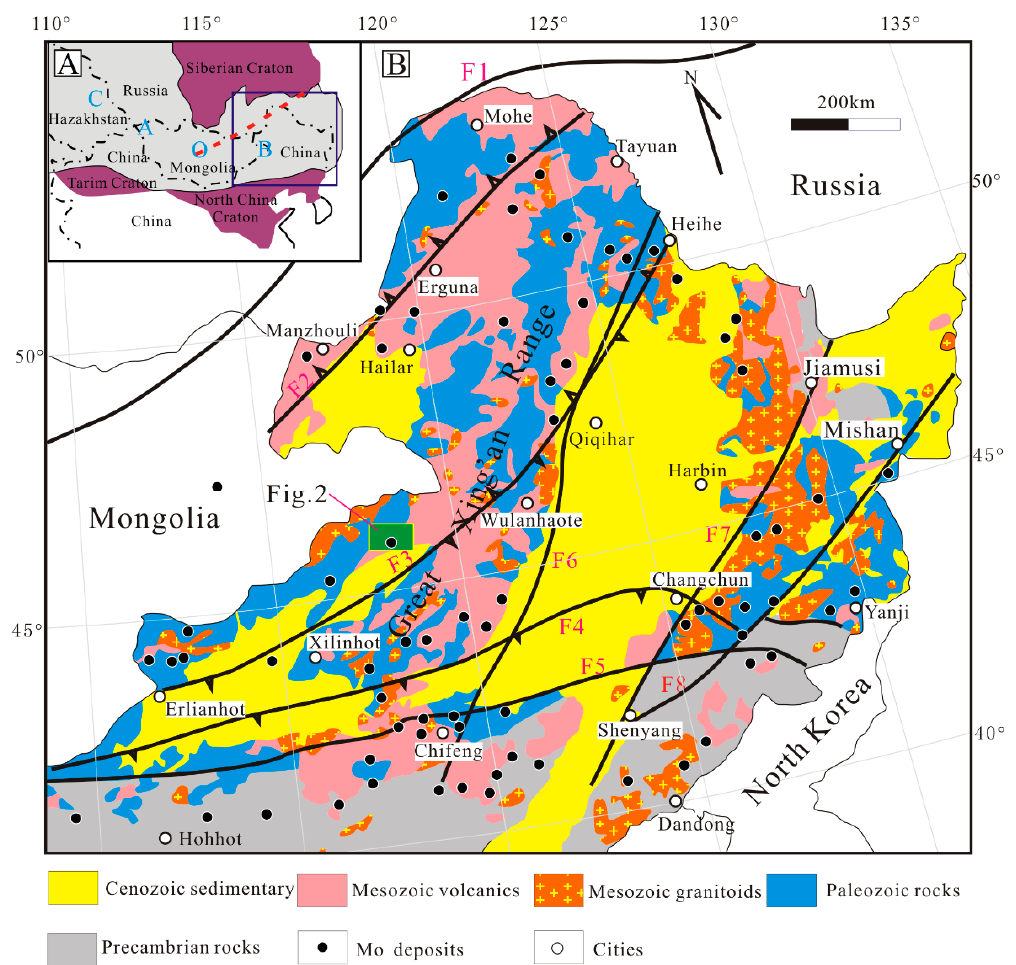
Figure 1. Distribution of the Mesozoic granitoids and Mo deposits in the Great Hinggan Range (GHR) and adjacent area. F1: Mongolia–Okhotsk suture belt; F2: Derbugan fault; F3: Erlian–Hegenshan Fault; F4: Xilamulun river fault; F5: Kangbao–Chifeng fault; F6: Nenjiang fault; F7: Yilan–Yitong fault; F8: Dunmi fault. CAOB: Central Asian Orogenic Belt. ( A ) Simplified tectonic map of CAOB showing major tectonic phases surrounding the GHR (modified after [2]). ( B ) Simplified geologic map of the GHR and its adjacent areas (modified after [9,23,24]).